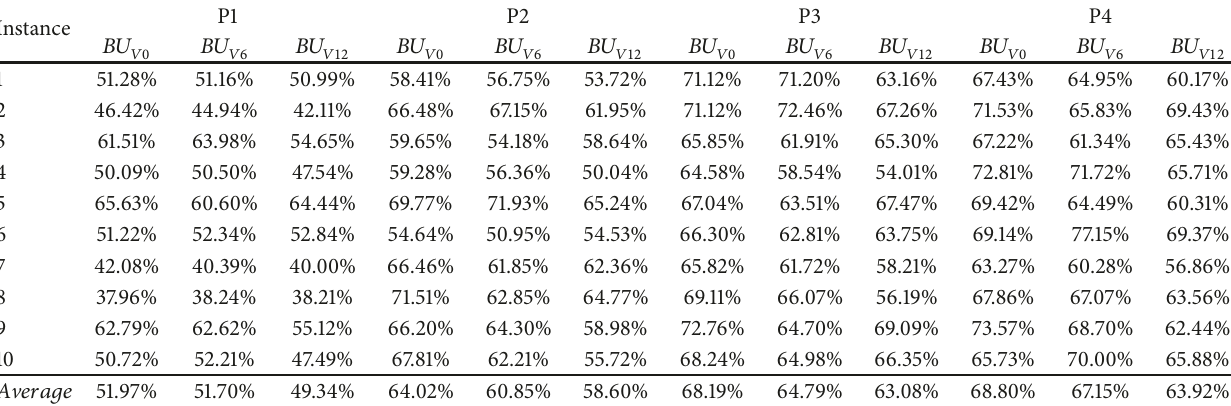
Table 8: Tidal impact on berth utilization ratio.